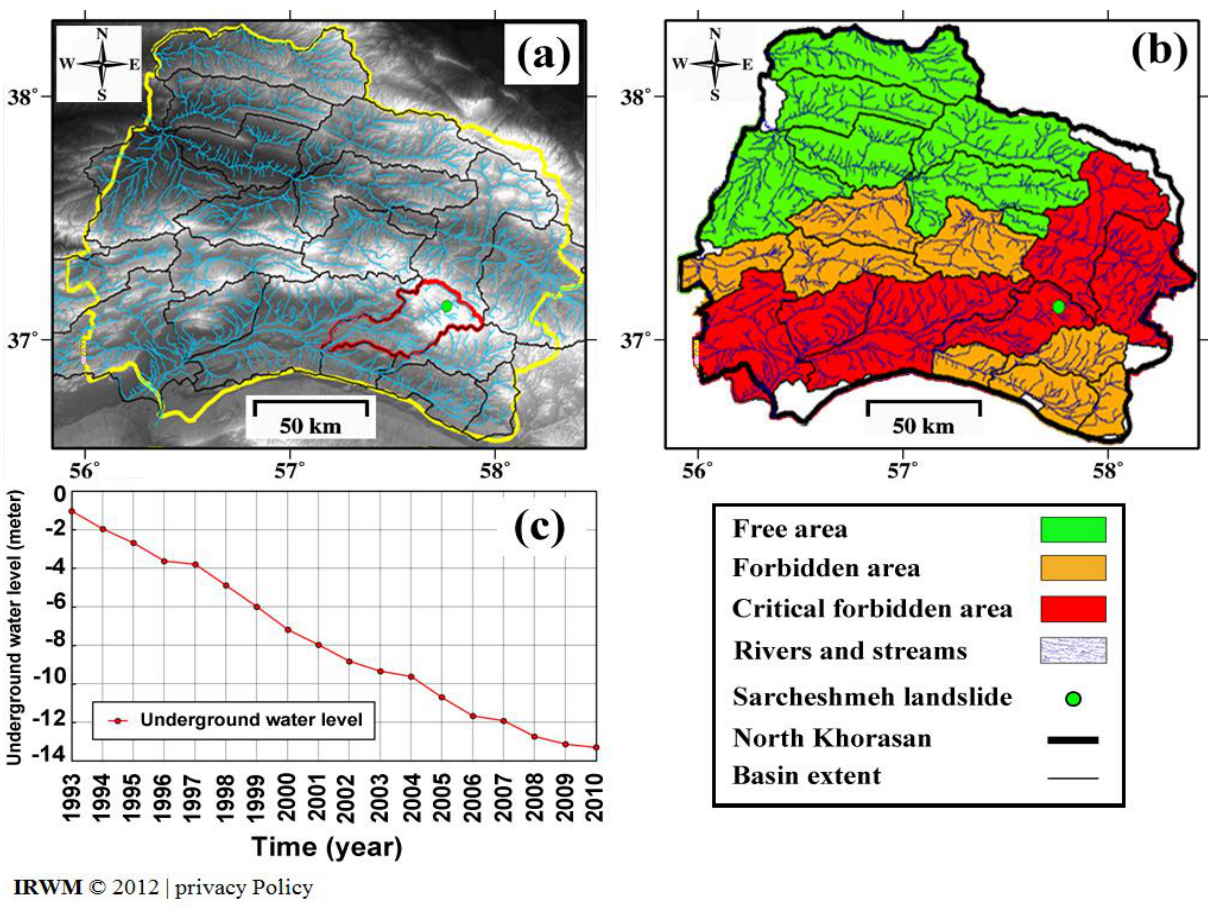
Figure 13. ( a ) Watershed basin segmentation map of the North Khorasan province. The red polygon delineates the watershed basin of Esfarayen to which the Sarcheshmeh slope belongs; ( b ) groundwater level status of each basin in the North Khorasan province indicated using different colors; ( c ) Groundwater level diagram of the Esfarayen basin which shows significant reduction from 1993 to 2010